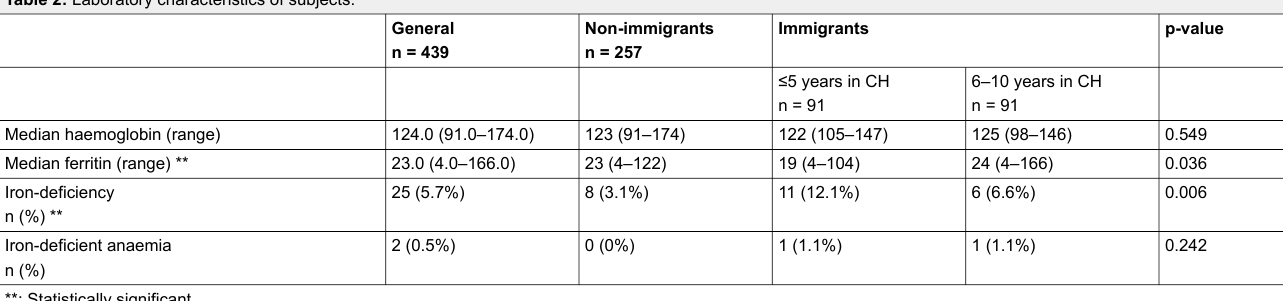
Table 2: Laboratory characteristics of